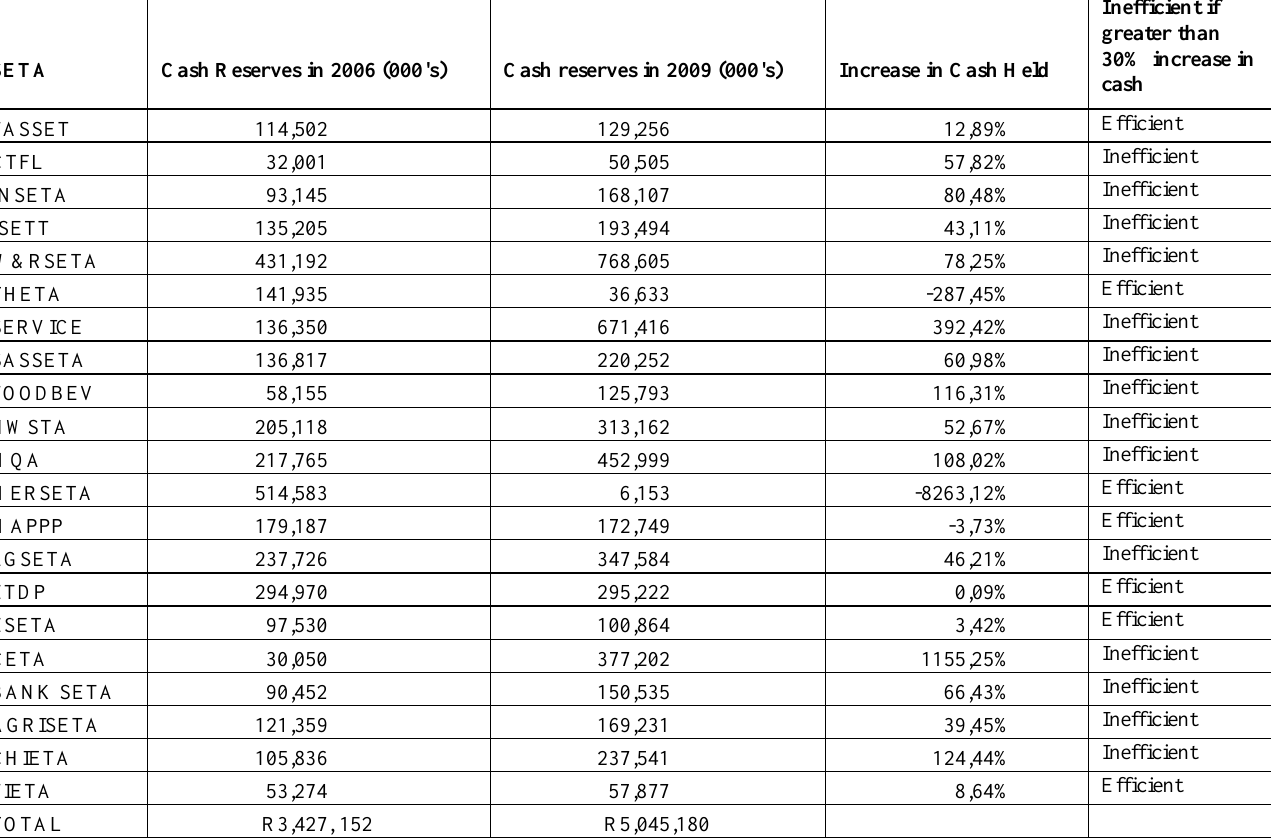
Table 2: Cash reserves of SETA’s 2006 – 2009